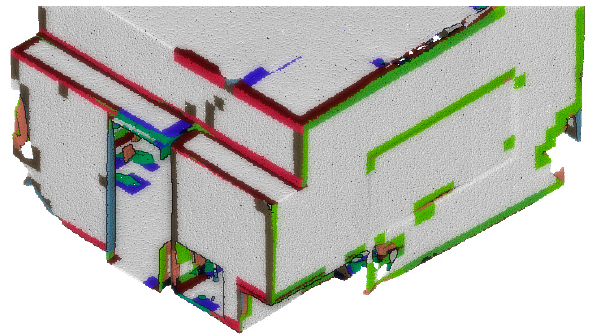
Figure 12: Edges elements to be decomposed in TE and RE. Figure 12. Edges elements to be decomposed in TE and